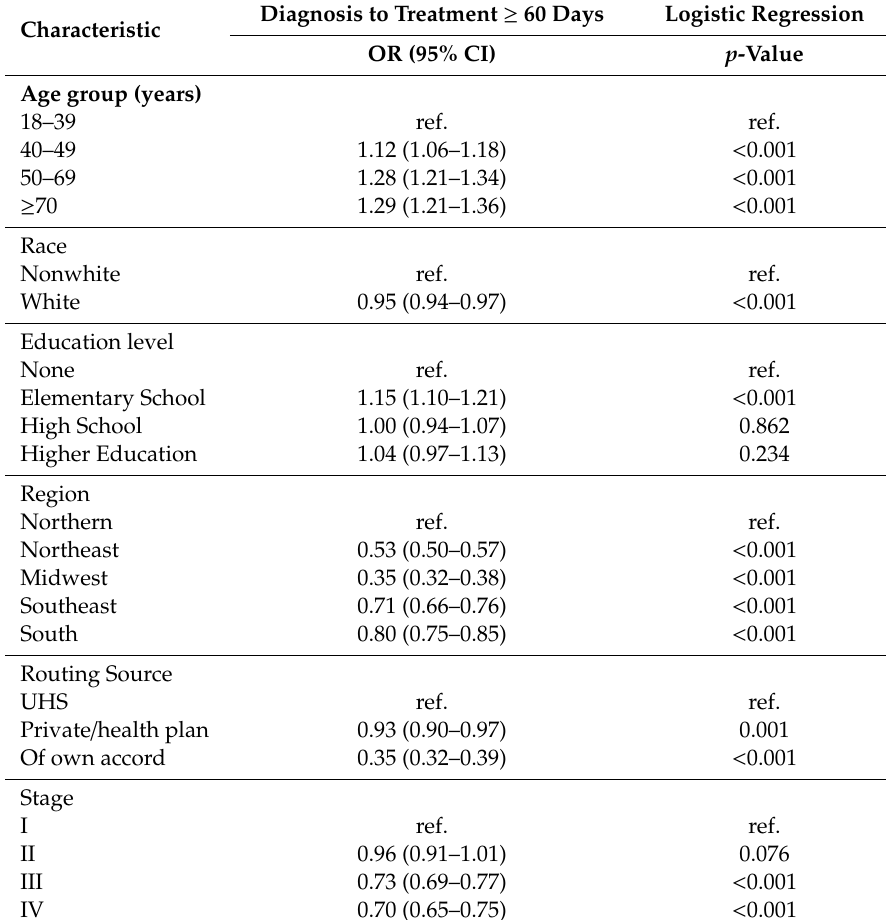
Table 3. Comparison of waiting time (days) between diagnosis and treatment in women with breast cancer and epidemiological characteristics in Brazil between 1998 and